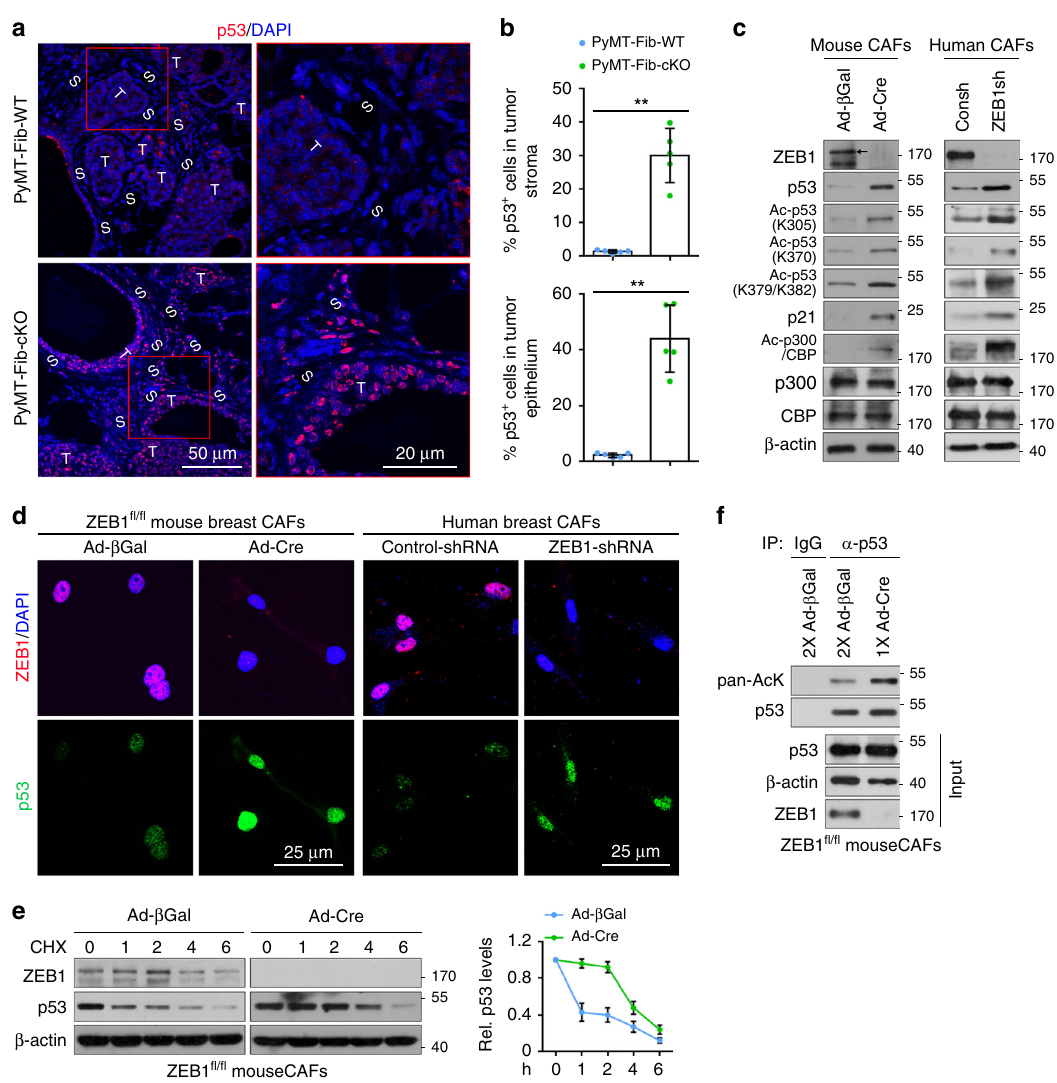
Fig. 6 ZEB1 functions as a p53 inhibitor in mammary stromal CAFs. a Immuno fl uorescence staining of p53 in PyMT-Fib-WT and -cKO tumours (images are representative of images from fi ve mice). Magni fi ed areas of boxed sections are shown in right panels. Nuclei are DAPI stained. b Quanti fi cation of p53- positive cells in stromal and epithelial compartments of the indicated primary tumours. Around 1000 cells are counted in ten random fi elds of each section ( n = 5 independent experiments). Two-sided Student ’ s t test. c Immunoblot (IB) analysis of primarily cultured control and ZEB1-deleted mouse (left panels) and human (right panels) breast CAFs using the indicated antibodies. d Immuno fl uorescence staining of ZEB1 and p53 in the indicated CAFs as described in c (representative images are from three independent experiments). Nuclei are DAPI stained. e Cycloheximide (CHX, 100 μ g/ml) pulse-chase analysis of p53 protein levels in control and ZEB1-deleted CAFs. Quanti fi cation of p53 protein expression levels are shown in right panels ( n = 3 independent experiments). f Lysates from control and ZEB1-deleted CAFs loaded at a ratio of 2:1 were subjected to immunoprecipitation (IP) and IB assays. Arrows mark-speci fi c bands with the expected molecular weights. All representative blots shown are from three independent experiments. All data are represented as mean ± s.d. ** P < 0.01. Unprocessed original scans of blots are shown in Supplementary Fig. 9. The source data are provided as a Source Data fi